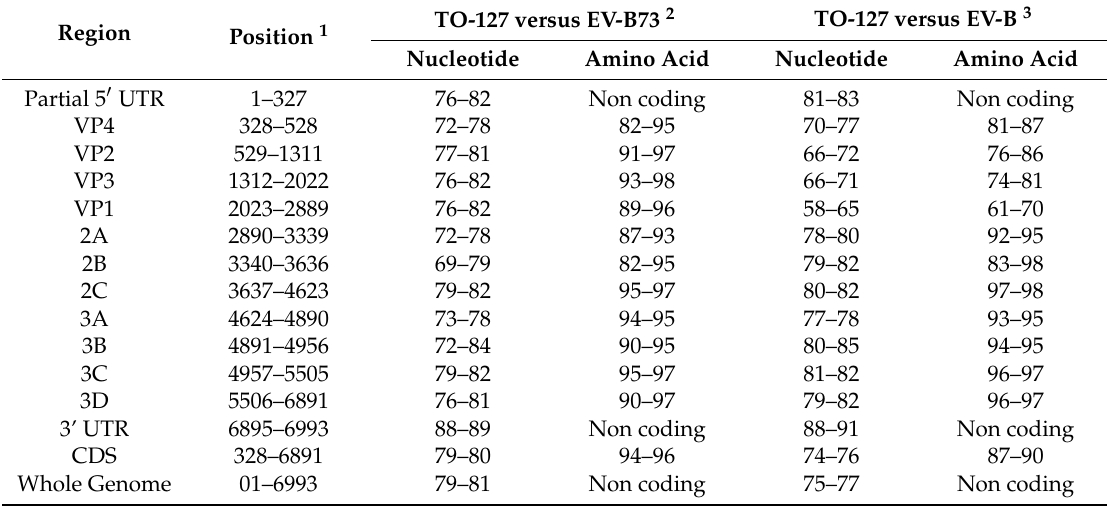
Table 1. Genome similarity (%) of TO-127 to EV-B73 and EV-B